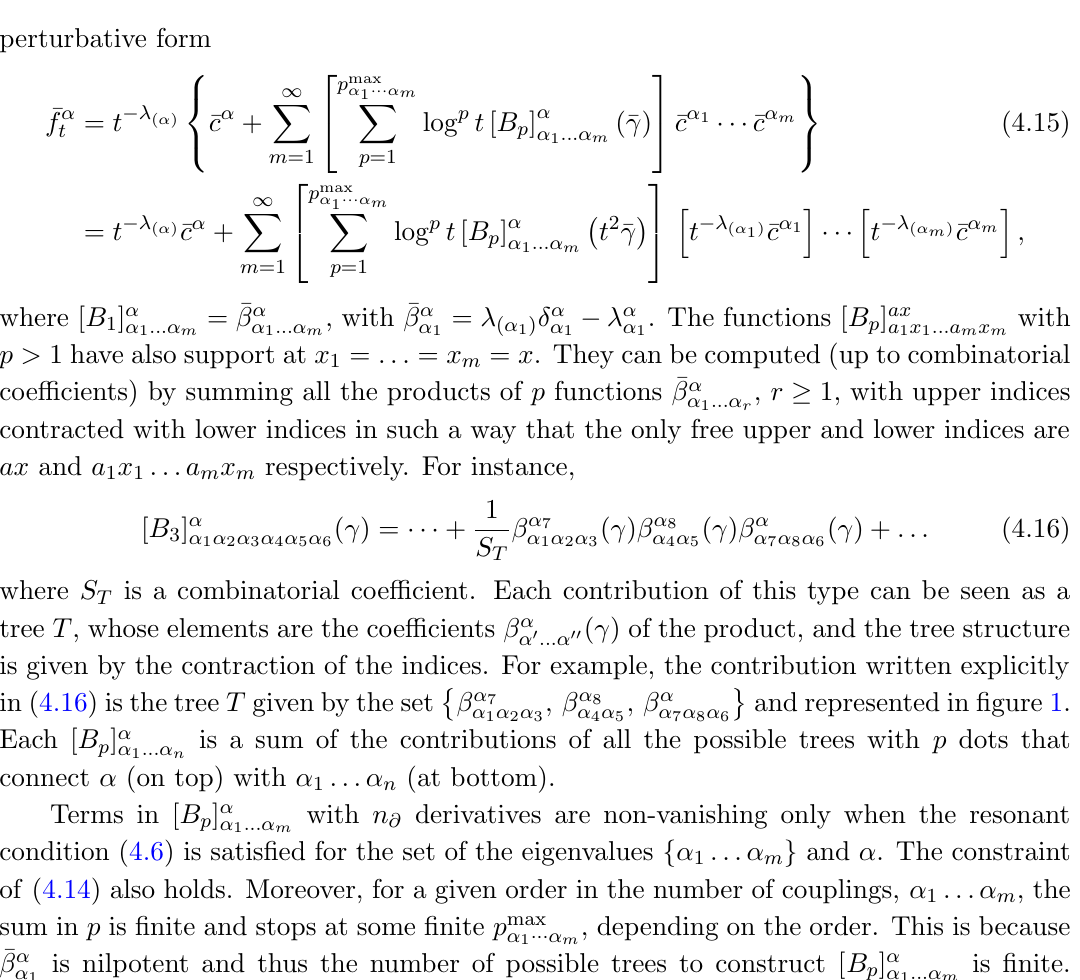
Figure 1 . Diagrammatic representation of the contribution to [ B p ] (cid:11) (cid:12) (cid:11) 7 (cid:12) (cid:11) 8 (cid:12) (cid:11) . Each dot represents a coe(cid:14)cient (cid:12) of the product. The index next to a dot (cid:11) 1 (cid:11) 2 (cid:11) 3 (cid:11) 4 (cid:11) 5 (cid:11) 7 (cid:11) 8 (cid:11) 6 is the upper index of the associated coe(cid:14)cient (cid:12) , while the indices to which the dot is linked to, downwards, are the lower indices of the associated coe(cid:14)cient (cid:12)